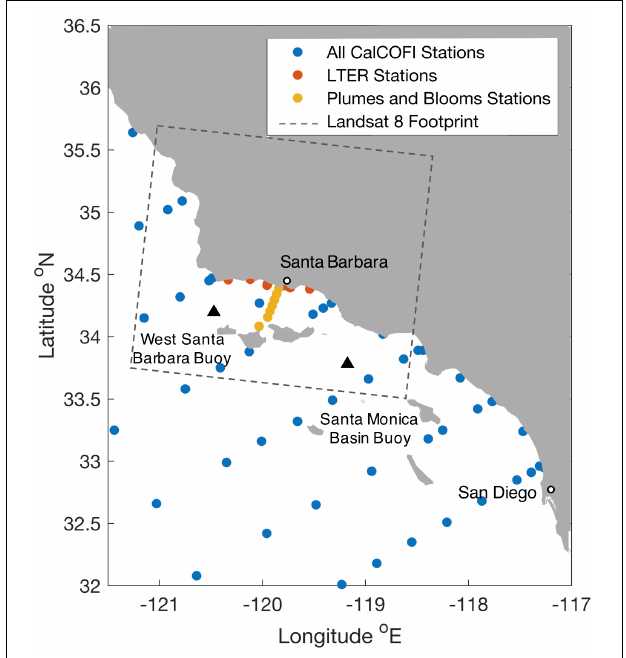
FIGURE 1 | In situ data collection sites (orange, yellow, and blue markers) in the Southern California Bight used for temperature to nitrate relationships in the Santa Barbara Channel,